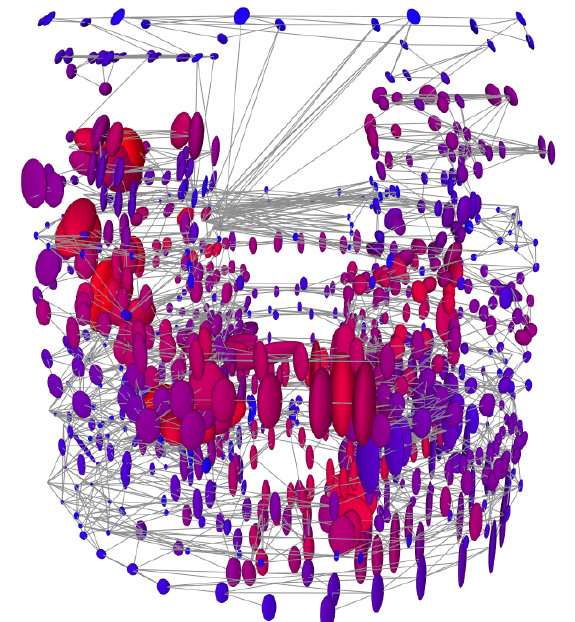
Figure 6: algebraic connectivity (from red to blue) and error ellipsoid through error propagation in the model of a kilo-station